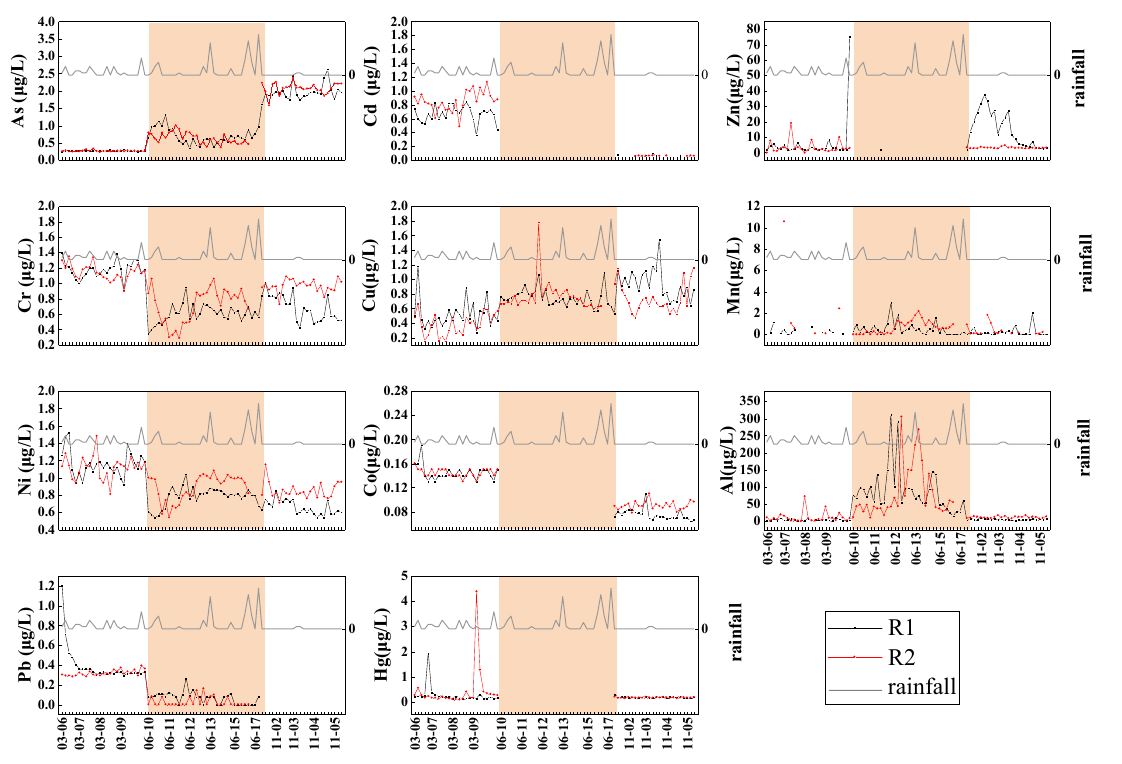
Figure 5. Average concentration variations of heavy metals at different water level operation peri- ods.